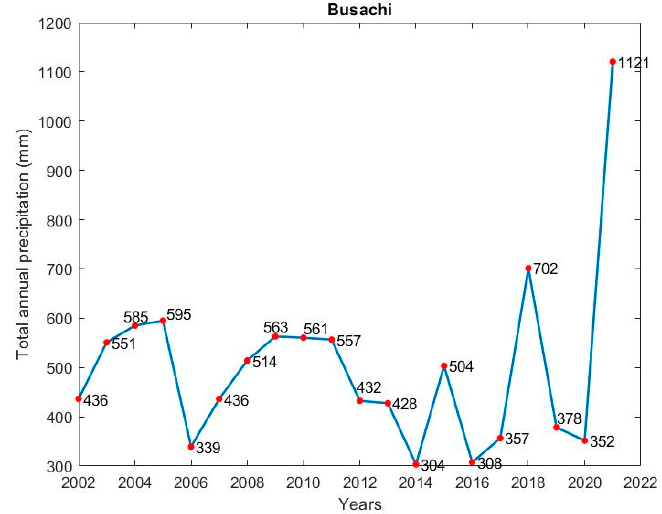
Figure 6. Trend of cumulative annual precipitation (mm) over the past twenty years (2002-2021) for the Busachi case study.